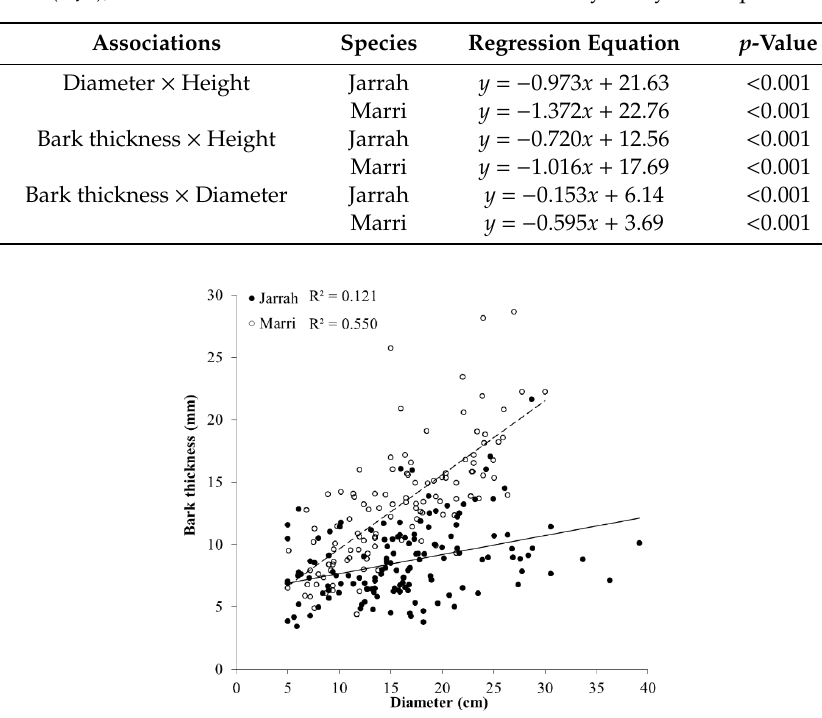
Table 1. Fitted models of diameter (cm) and bark thickness (mm) as a function of height (m), and bark thickness as a function of diameter for jarrah ( Eucalyptus marginata ) and marri ( Corymbia calophylla ) trees infested by the Australian eucalyptus longhorned borer Phoracantha semipunctata in the Northern Jarrah Forest (NJF), Southwestern Australia. Associations were analysed by least squares regression.